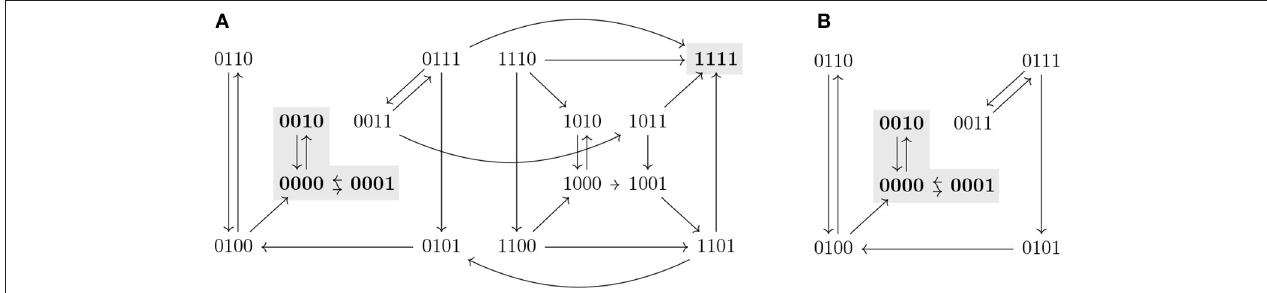
, with (cid:127) = 0 ∗∗∗ , are represented in (A,B) , respectively. Attractors are marked in (cid:127)